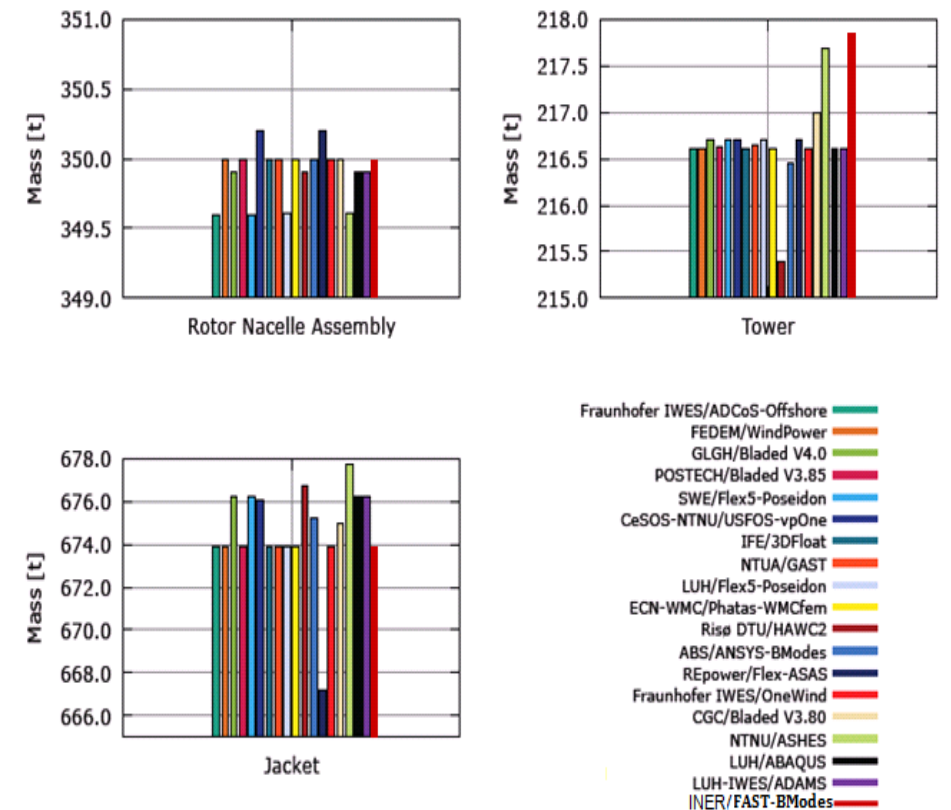
Figure 8. Masses of OWTG (Offshore Wind Turbine Generator) Components.